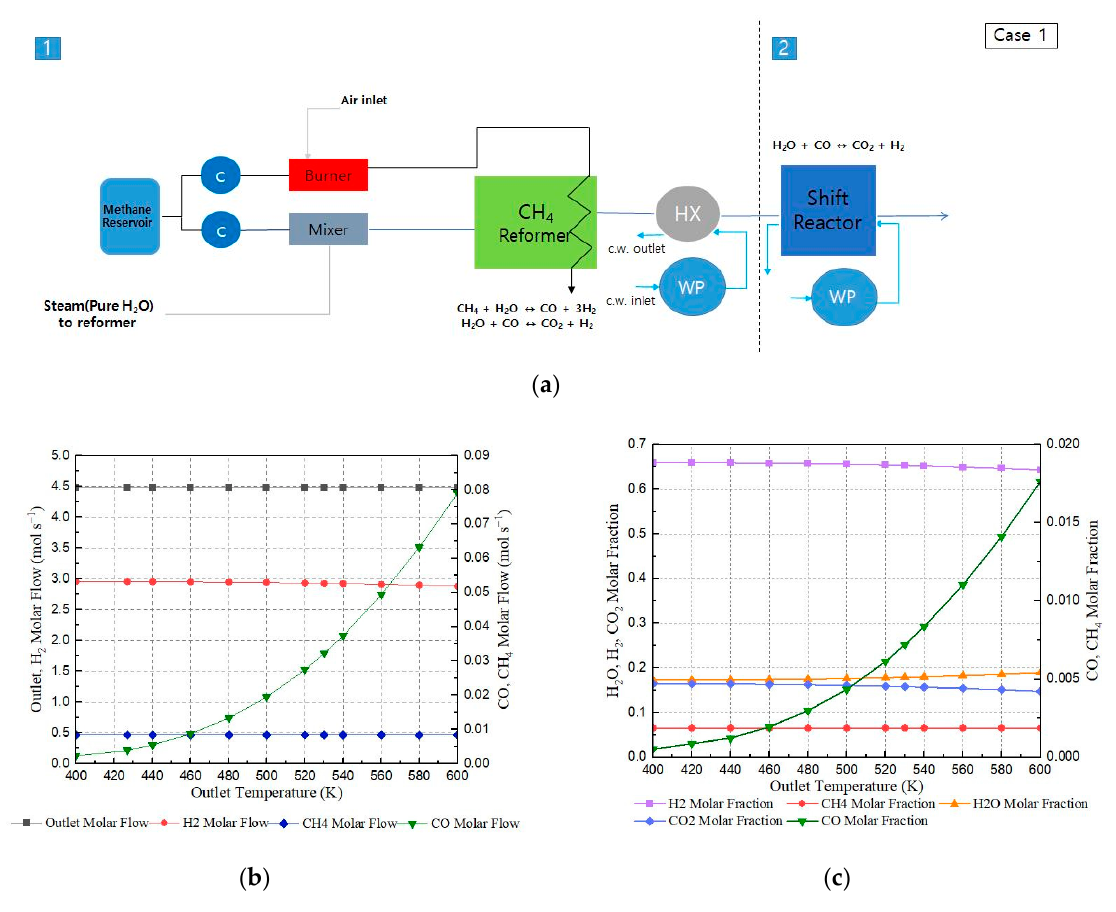
Figure 4. ( a ) Schematic of methane reforming system for PEMFCs, Graph of ( b ) molar flow and ( c ) molar fraction of outlet side (Case 1).